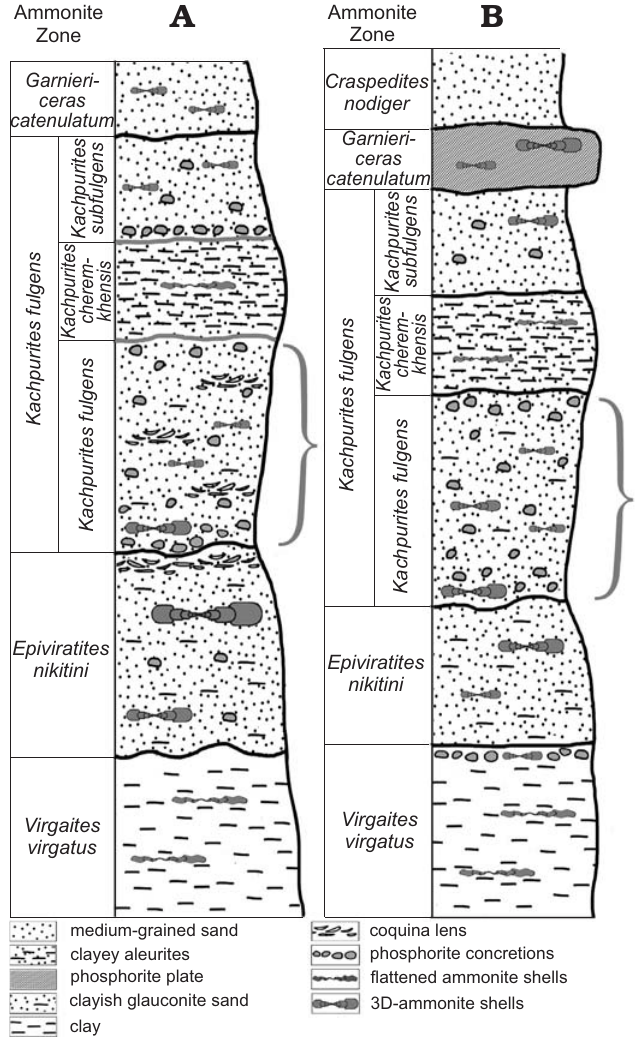
Fig. 2. Stratigraphic column of the localities. A . Mnevniki, Moscow. B . Eganovo, Moscow area. The braces mark the horizon from which the described ammonites have been collected. Ammonite zones (see Rogov and Starodubtseva 2014). The total thickness of the layers is about 2